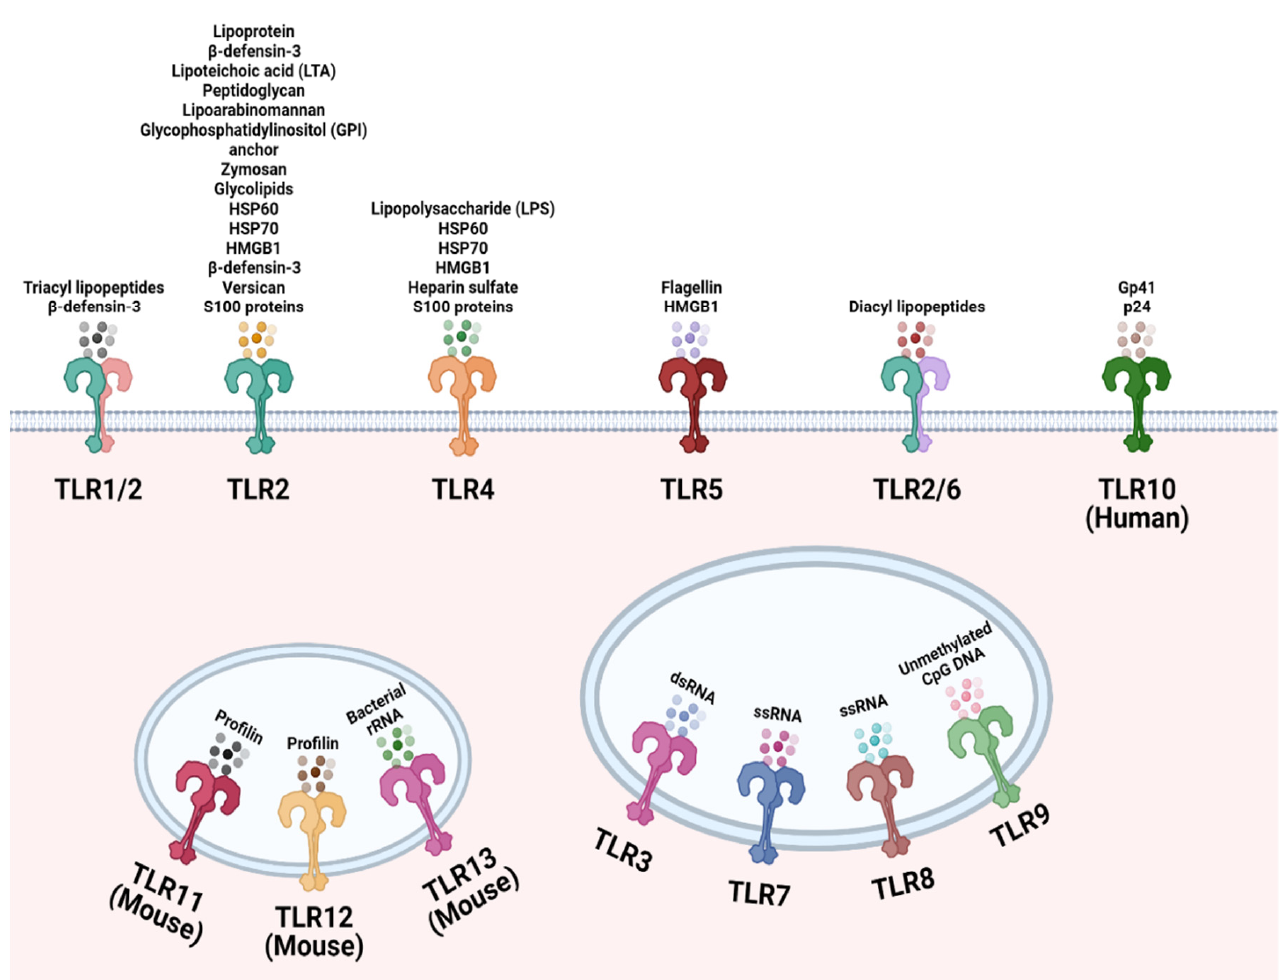
Figure 1. Cellular localization of the Toll-like receptor (TLR) family. TLR1, TLR2, TLR4, TLR5, TLR6, and TLR10 are localized to the cell surface to recognize common microbial structural components and endogenous ligands. TLR3, TLR7, TLR8, TLR9, TLR12 and TLR13 are located on endosomes to sense microbial nucleic acids that have entered the cell. TLR11 and TLR12 are localized to endosomes to recognize Toxoplasma gondii derived profilin. Created with Biorender.com.